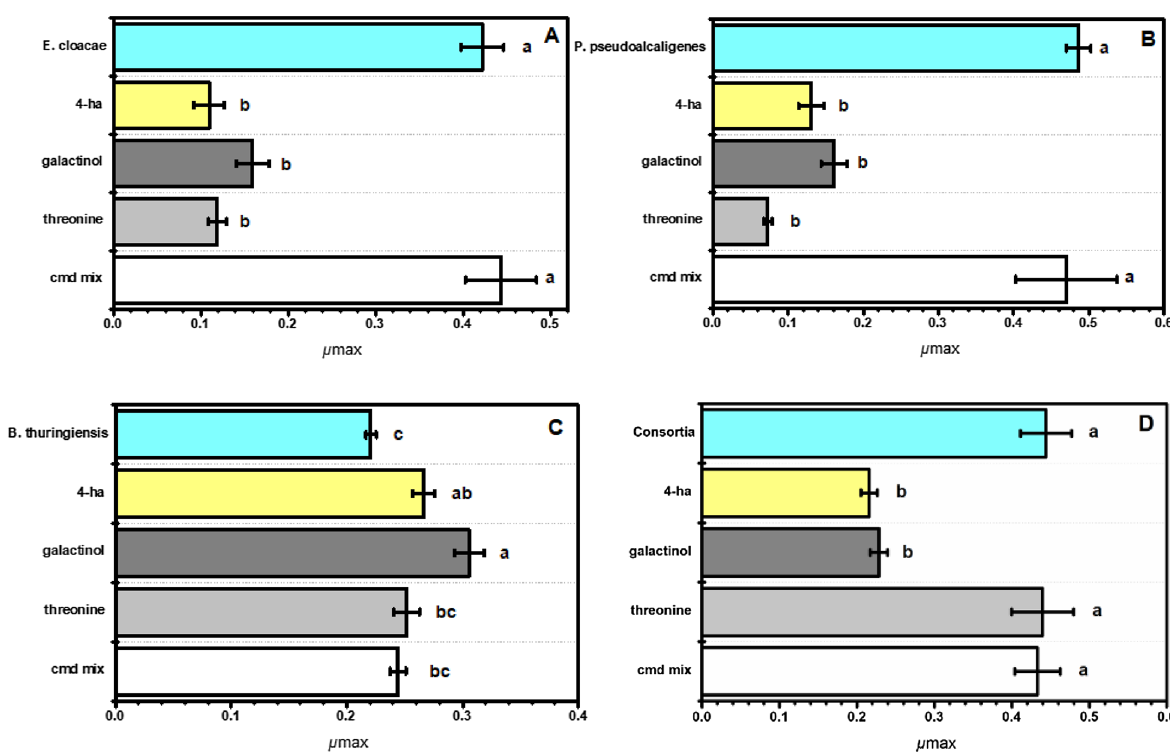
Figure 1. Maximum specific growth rate ( μ max ) of P solubilizing bacteria incubated with different root exudates under inorganic calcium phosphate media. Each panel corresponds to ( A ) Enterobacter cloacae , ( B ) Pseudomonas pseudoalcaligenes , ( C ) Bacillus thuringiensis , ( D ) bacteria consortium. Y-axis shows from top to bottom the control: individual bacteria or consortium in blue; 4-ha: 4-hydroxybutyric acid in yellow; galactinol in dark gray; threonine in light grey; and cmd mix: compound combination in white. A one-way ANOVA was performed to compare the effect of root exudates on bacteria. Tukey’s HSD test for multiple comparisons show significant differences. Different letters denote statistical significance among treatments ( p-value <